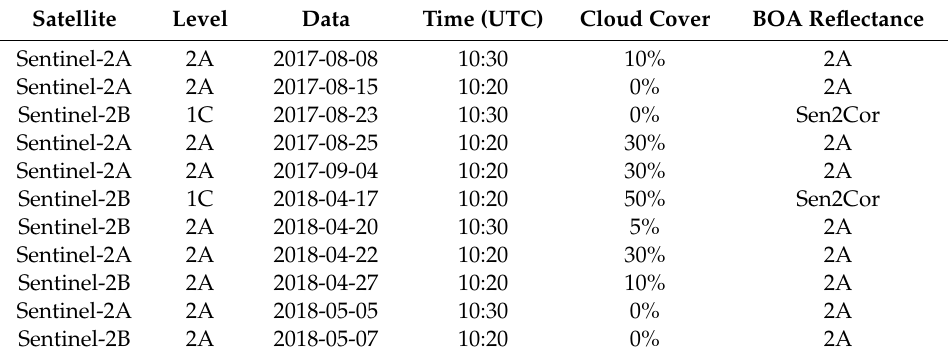
Table 2. Overview of applied Sentinel-2 data sets for the test sites in 2017 and 2018.